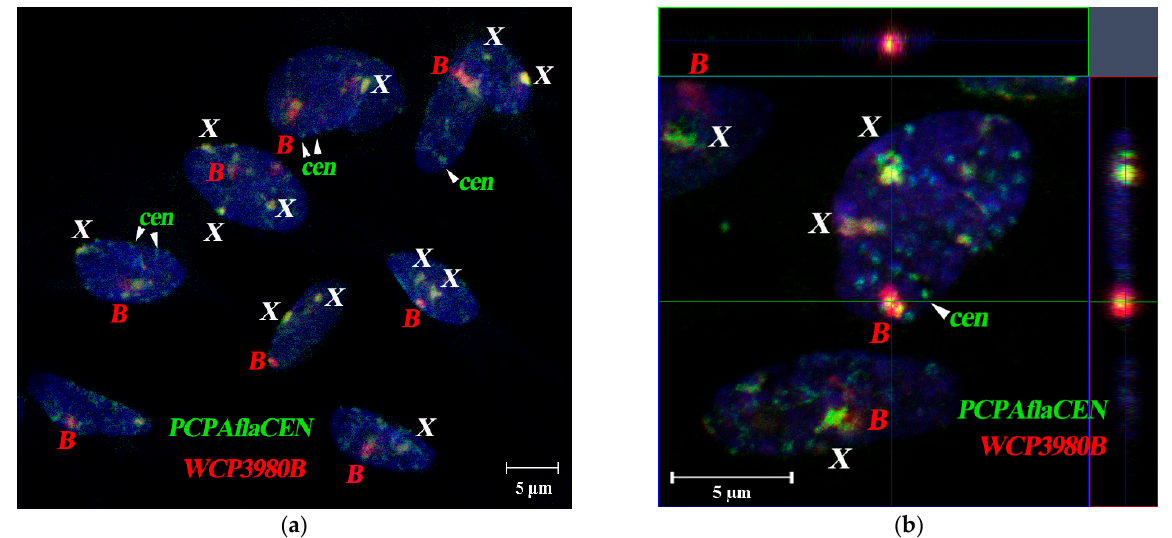
Figure 8. The 3D-FISH of the B-specific probe (WCP3980B, red signal) and the probe to pericentromeric heterochromatin of A-chromosomes (PCPAflaCEN, green signal) in the interphase nuclei of fibroblast from females with one B #3980 (Orašac, Serbia). ( a ) Group of fibroblast nuclei; ( b ) orthogonal projection, demonstrating the location of the Bs (red) and pericentromeric heterochromatin regions of As (green) in the interphase nuclei of fibroblasts of A. flavicollis . The blue, green and red lines indicate the location of axial, frontal, and sagittal optical sections, respectively. The axial optical section is in the center (xz), the frontal one is on top (xy), the sagittal one is on the right (yz). Co-localization of FISH-signals from B-specific probe and the PCPAflaCEN probe on X chromosomes (yellow). Bs and X chromosomes are marked by corresponding letters; cen—point to autosomal C-positive regions; DAPI staining is blue. Scale bar 5 µm.